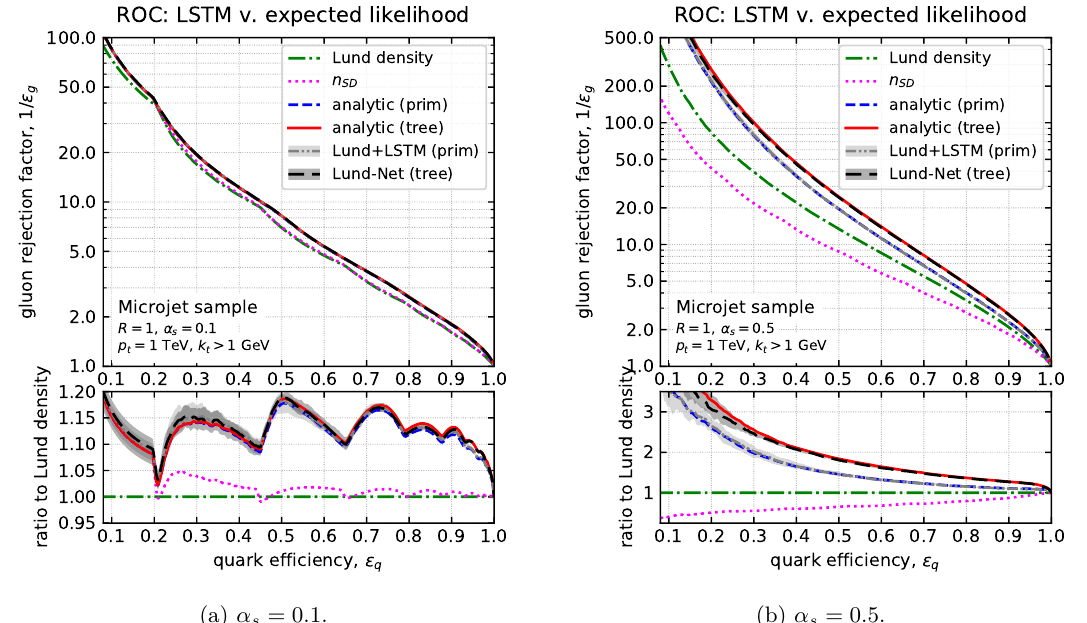
Figure 4. The ROC curves for the analytic and ML classifiers for the microjet sample. For this sample, our analytic approach is exact, showing that the neural networks capture the full (single- logarithmic) information in the training